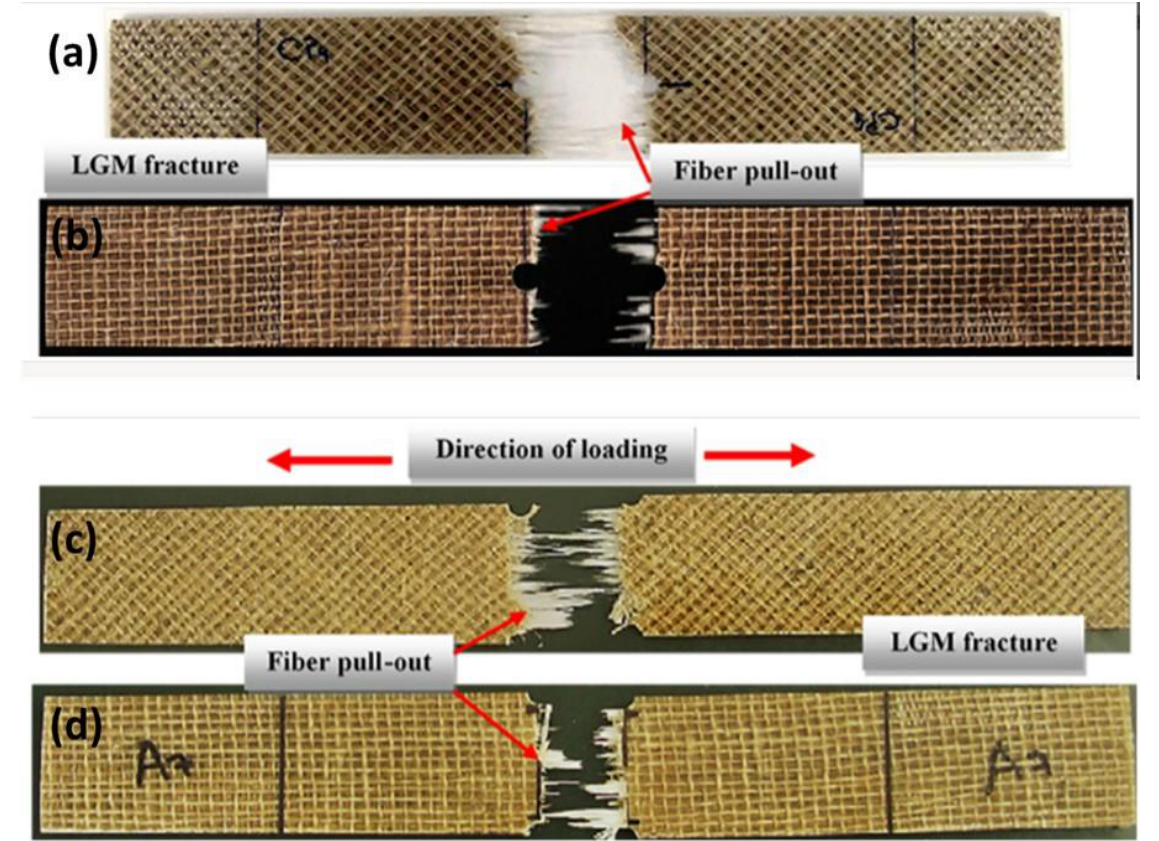
Figure 3. Residual strength for different fiber orientations and positions of a hole [86].